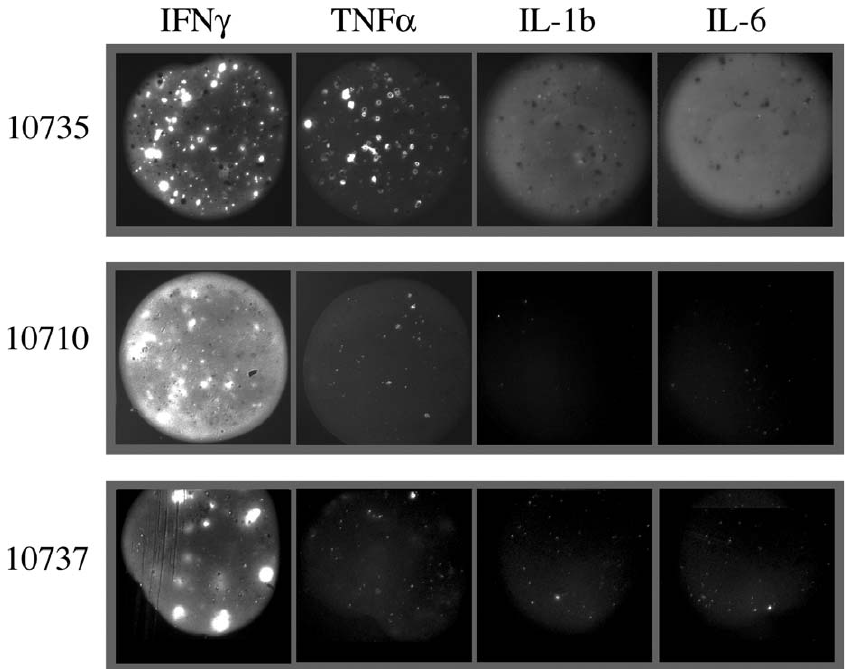
Figure 6. Differences in Functional Profiles between Three Patients with Different Clinical Outcomes gp100 209–2M spots co-spotted with anti-IFN c , anti-TNF a , anti-IL1b, and anti-IL-6 are shown for three separate patient samples. Patient 10735, who remains free of disease at this writing, displays strong IFN c , TNF a , IL-1b, and IL-6 secretion. Patients 10710 and 10737 show strong IFN c secretion, but weak to no TNF a , IL-1b, and IL-6 secretion; both patients experienced disease recurrence soon after these samples were drawn. Note the diffuse pattern of IL-1b and IL-6 capture, which differs from the focal capture of IFN c and TNF a . DOI: gp100 209/HLA-A2.1 (wild-type peptide sequence). All five tested samples showed functional responses to wild-type gp100 209/HLA-A2.1 that mirrored the measured response to gp100 209–2M/HLA-A2.1 (unpublished data). Cytokine de-